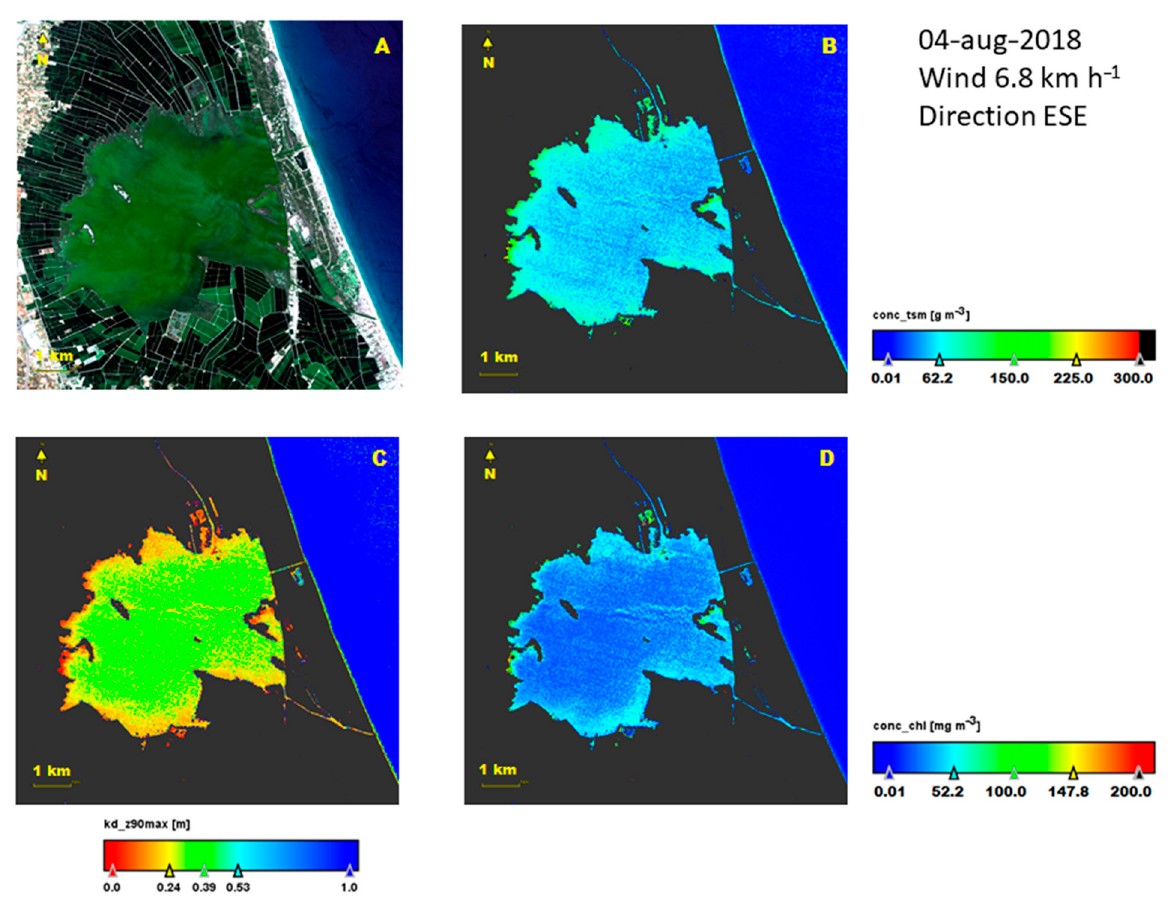
Figure 7. Sentinel-2 image and thematic maps of the variables on a day with an easterly light breeze. The rice field is flooded and with overgrown rice plants. ( A ) False color RGB; ( B ) TSM concentration map; ( C ) Transparency map; ( D ) chlorophyll a concentration map.